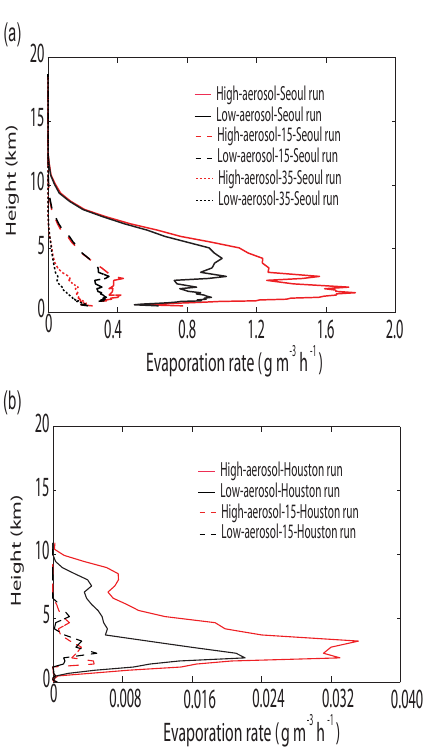
Figure 12. Distributions of normalized precipitation frequency over precipitation rates for (a) the Seoul case and (b) the Houston case. Solid lines represent simulations at the 500m resolution, while dashed lines represent those at the 15km resolution. Dotted lines represent simulations at the 35km